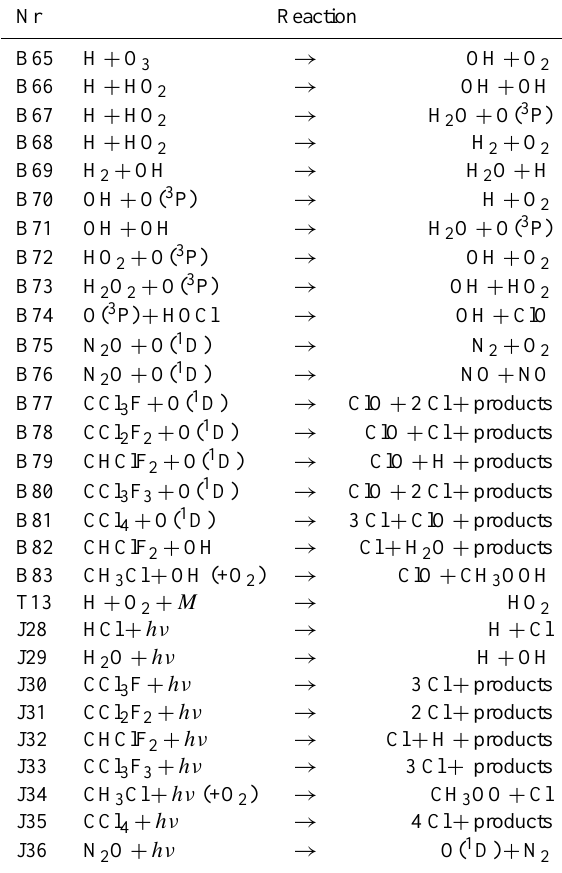
Table A1. Reactions included into the CLaMS chemistry. Only the additional reactions are listed, which were not described by McKenna et al. (2002b), from which the bimolecular reac- tions (B1–B64), trimolecular or thermal decomposition reactions (T1–T12), photolysis reactions (J1–J27) and heterogeneous reac- tions (H1–H11) are used. Carbon and Fluorine containing products from halocarbon decomposition are